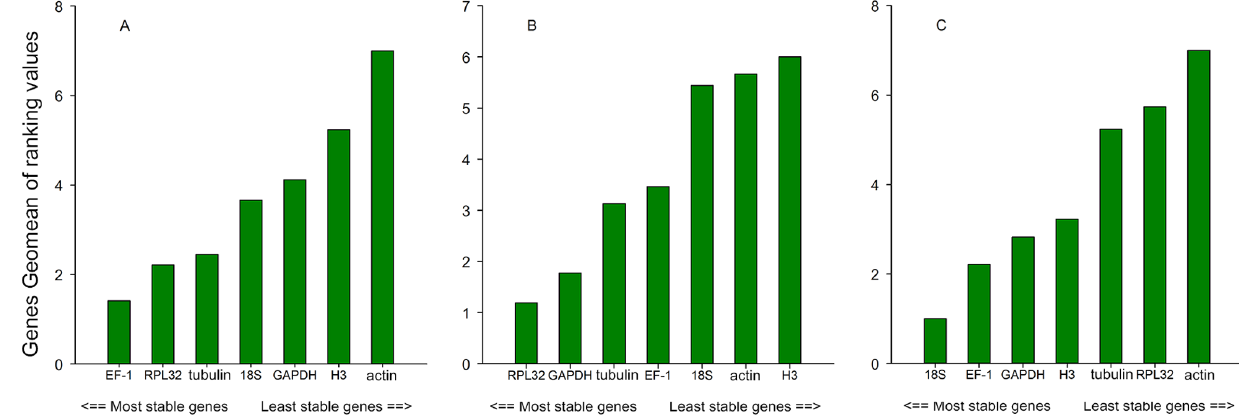
Figure 2. Expression stability of the candidate reference genes as calculated by the Geomean method of RefFinder. A lower Geomean ranking indicates more stable expression. Expression stability of reference genes in the following samples: A) different developmental stages of Frankliniella occidentalis ; B) F. occidentalis exposed to high temperatures; C) F. occidentalis exposed to low temperatures.